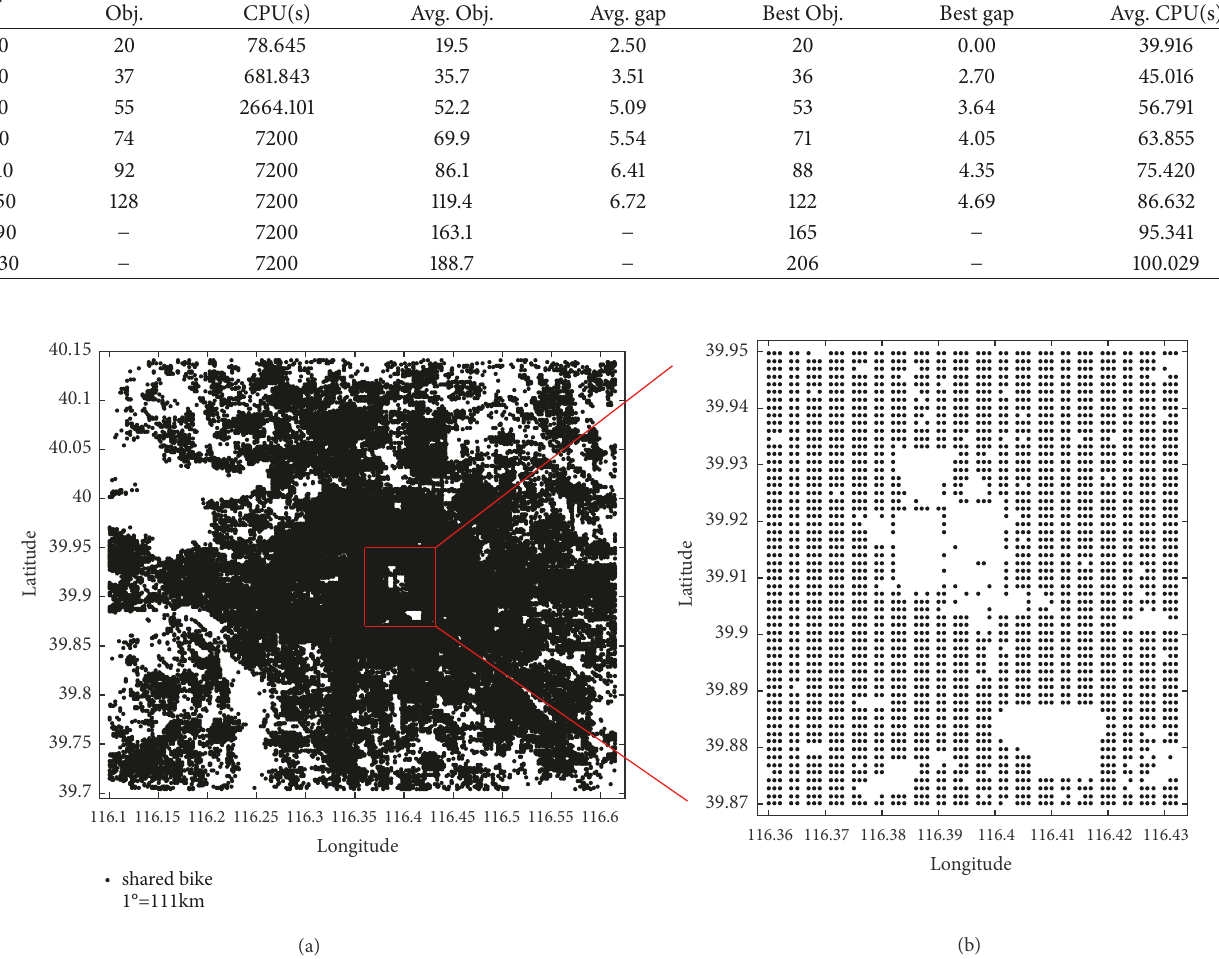
Figure 5: Location of shared bikes in the area of: (a) sixth loop of Beijing and (b) second loop of Beijing. The black dots represent the location of shared